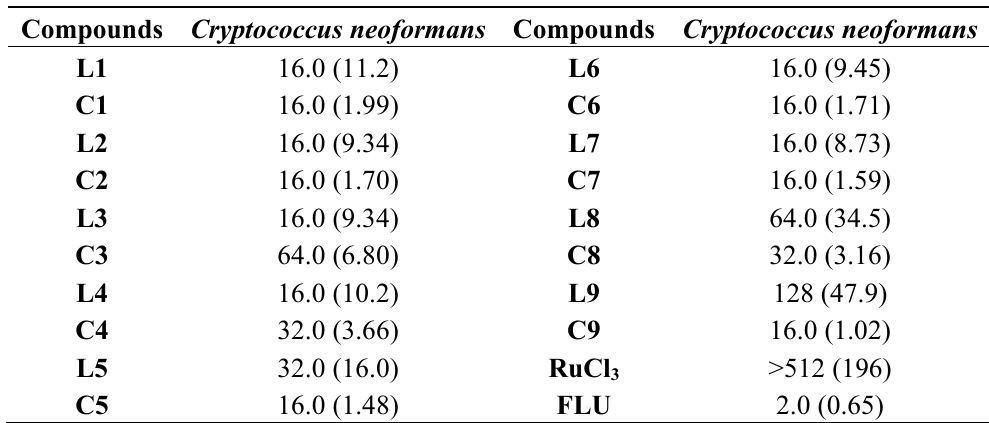
Table 5. In vitro susceptibility of clinical isolates of Cryptococcus neoformans for pentakis-dithiocarbamate diruthenium complexes by broth microdilution